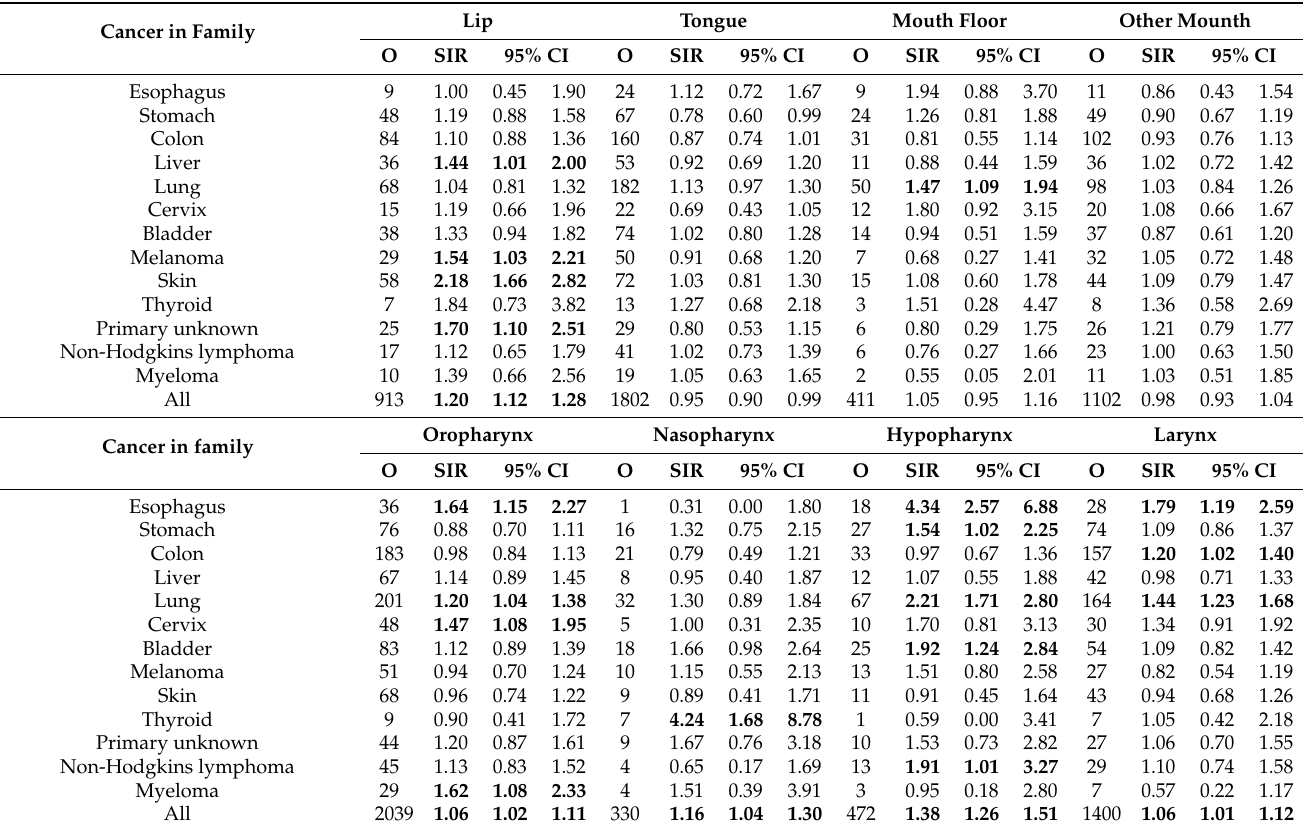
Table 5. Familial risk of site-specific head and neck cancers when family members were diagnosed with any cancer. Cancer in